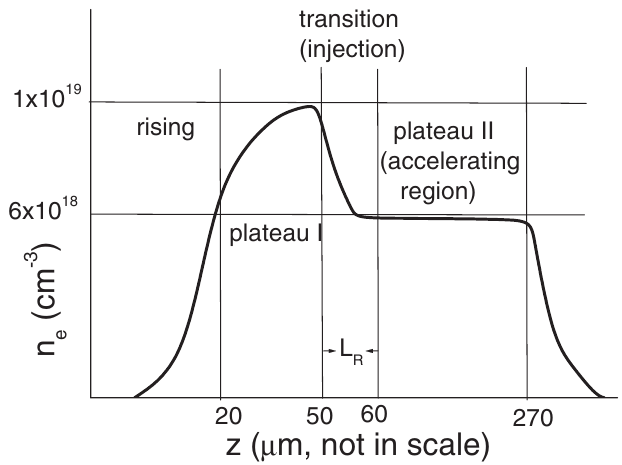
FIG. 3. Background plasma density useful for e-beam injec- tion and acceleration.